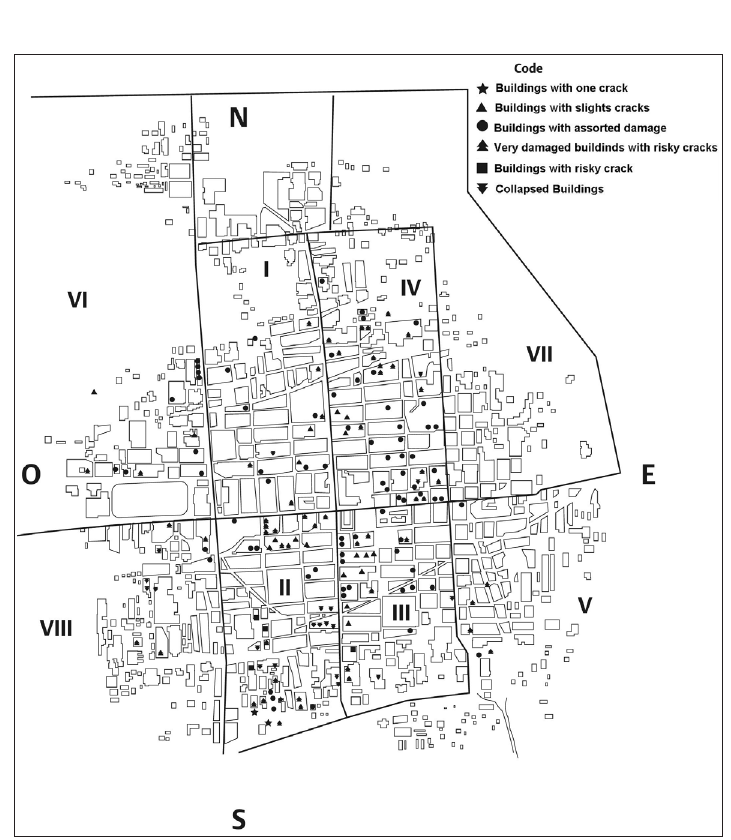
Fig. 2. Effects of the 8 March 1800 earthquake in Mexico